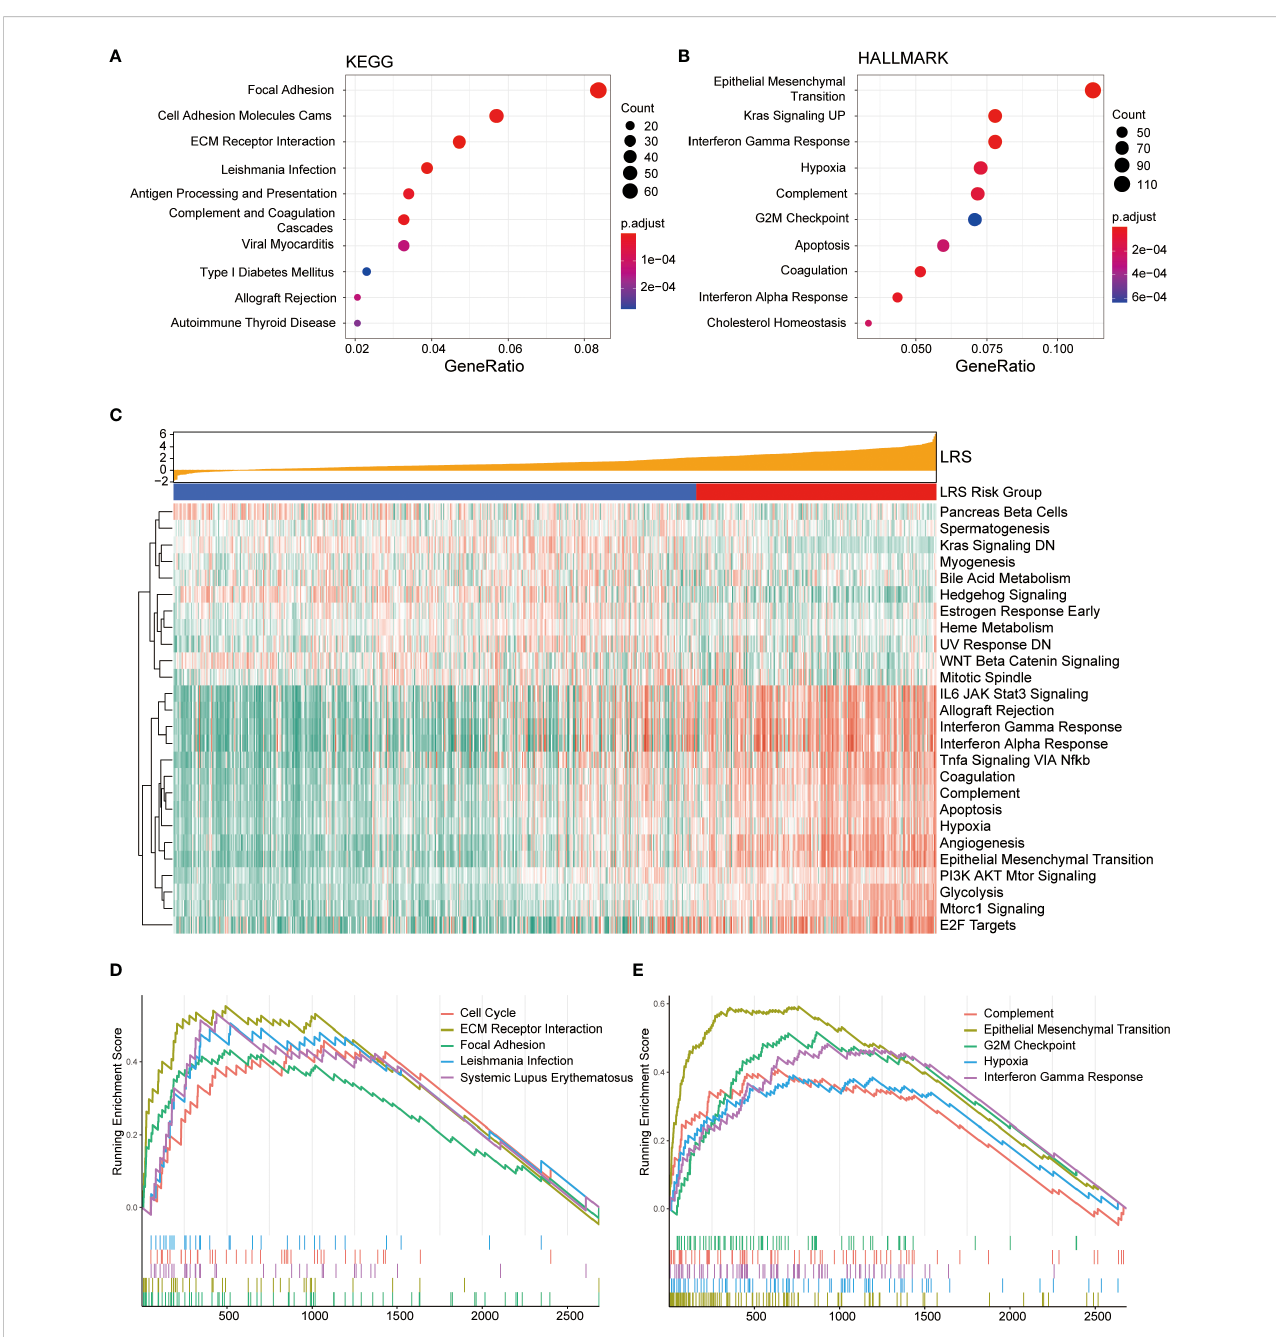
FIGURE 7 Functional enrichment analysis of DEGs from low- and high-risk groups. Top 10 over-represented KEGG pathways (A) and Hallmark pathways (B) ; (C) , Association between LRS and expression of Hallmark gene sets based on GSVA; Top 5 KEGG (D) and Hallmark gene sets (E) with highest normalized enrichment score based on